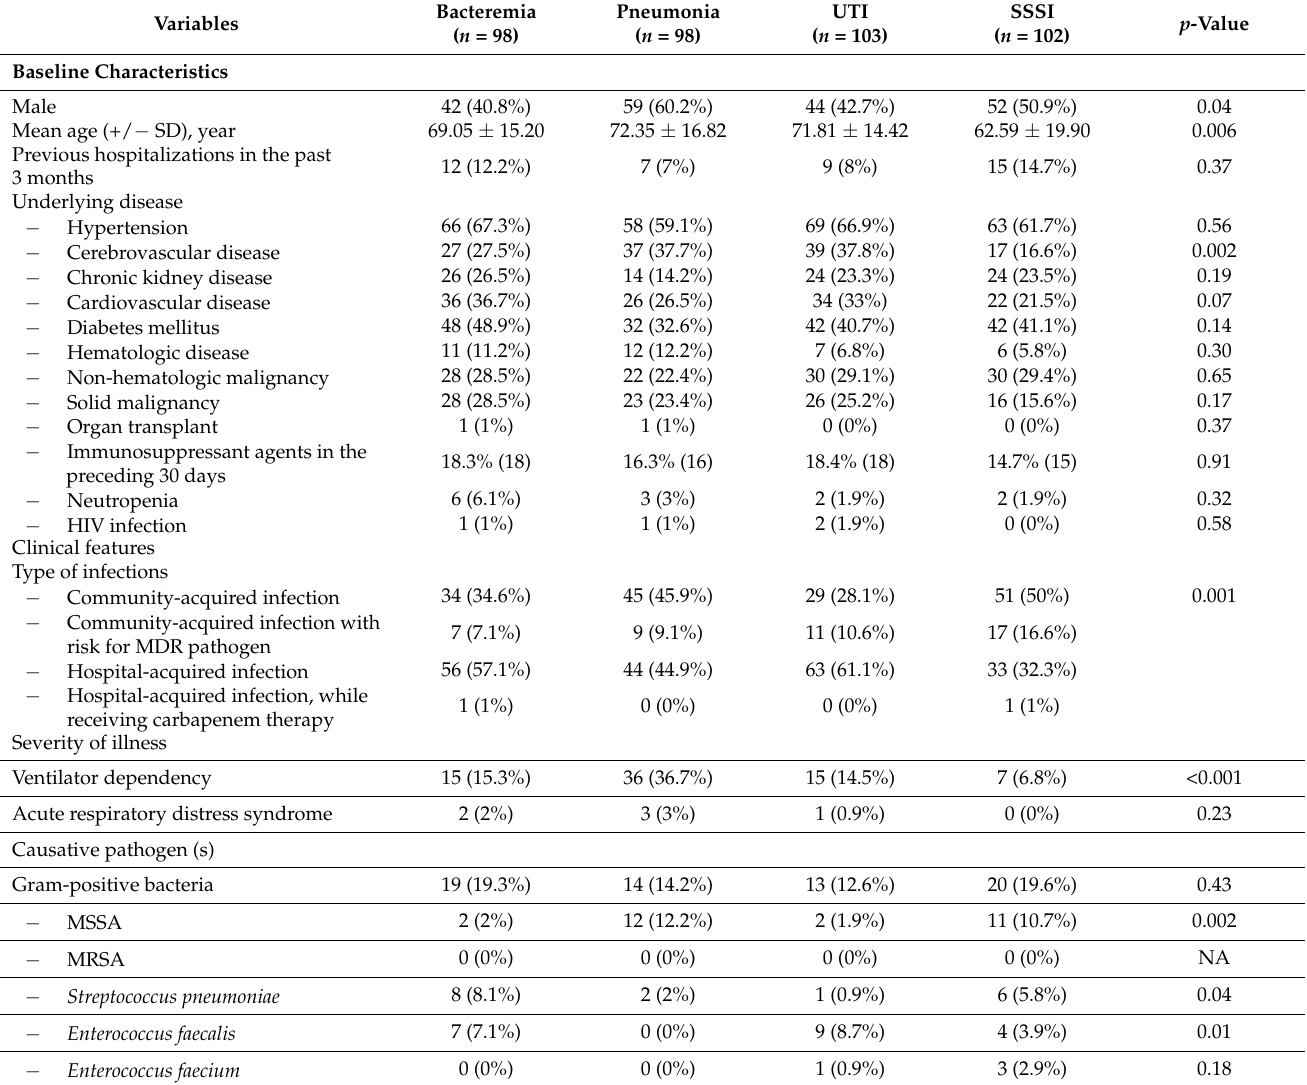
Table 1. Baseline characteristics, clinical features, and treatment outcomes, stratified by the site- specific